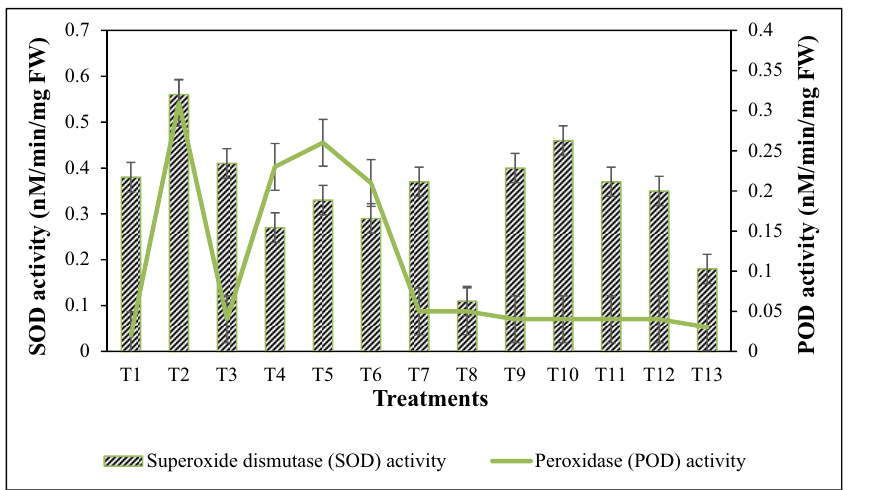
Figure 7: E ff ect of di ff erent treatments of NPs alone or in combination with TDZ on SOD and POD activity in callus cultures of A. absinthium .